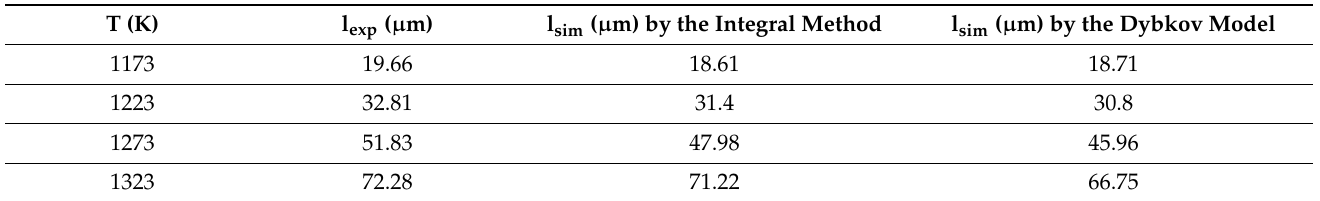
Table 7. Experimental and simulated layers’ thicknesses of Fe 2 B for 10 h at different temperatures. T (K)